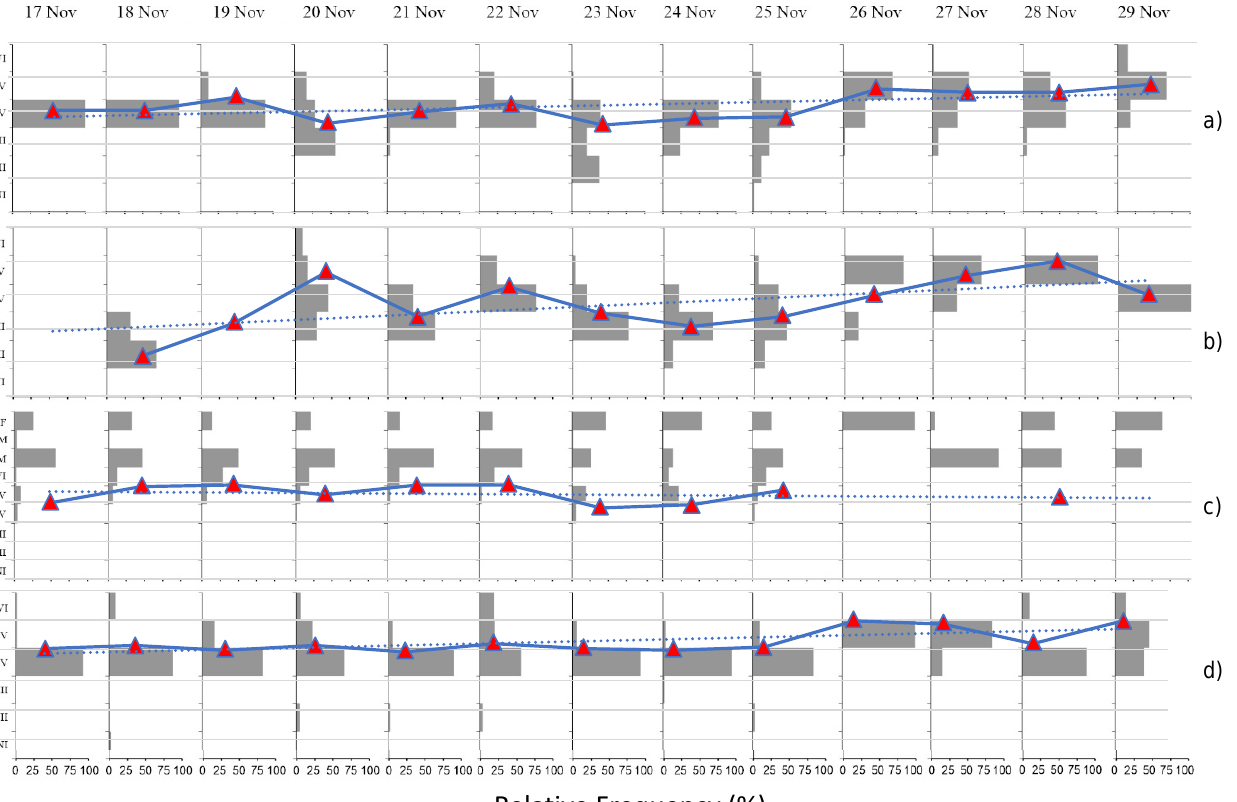
Figure 10. PIPEX 97 cruise, Terra Nova Bay, Antarctica 1997. Frequencies of occurrence and mean naupliar stage ( ) of the most abundant copepod species throughout the sampling period: ( a ) Stephos longipes , ( b ) Paralabidocera antarctica , ( c ) Oithona similis , ( d ) Metridia gerlachei . Note that naupliar stages NI and NII were not found for the species O. similis , which presented conversely copepodites (only CV) and male/female adults.